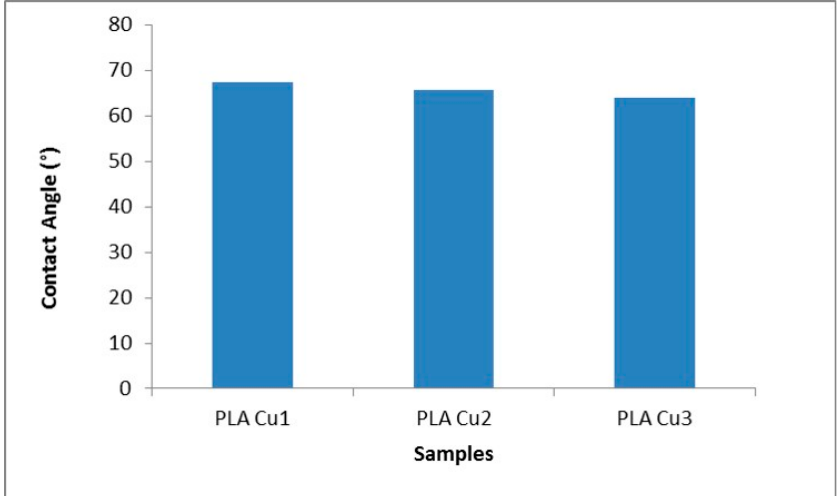
Figure 12. Contact angle values for PLA 600-Cu composites.